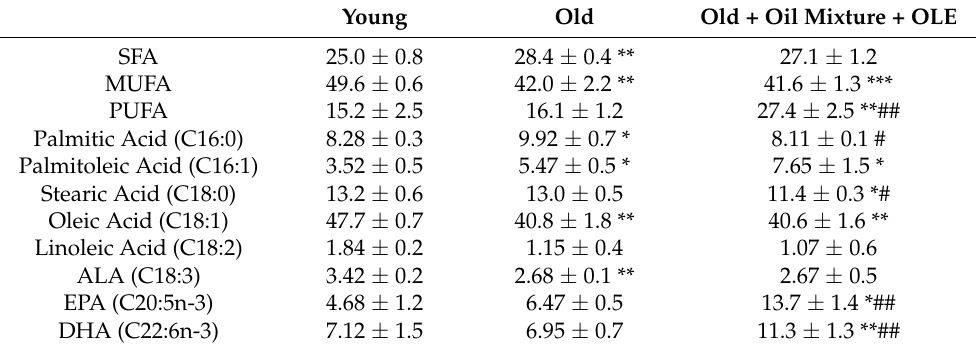
Table 4. Fatty acid proportion (%) of young rats, old rats and old rats treated with oil mixture and the